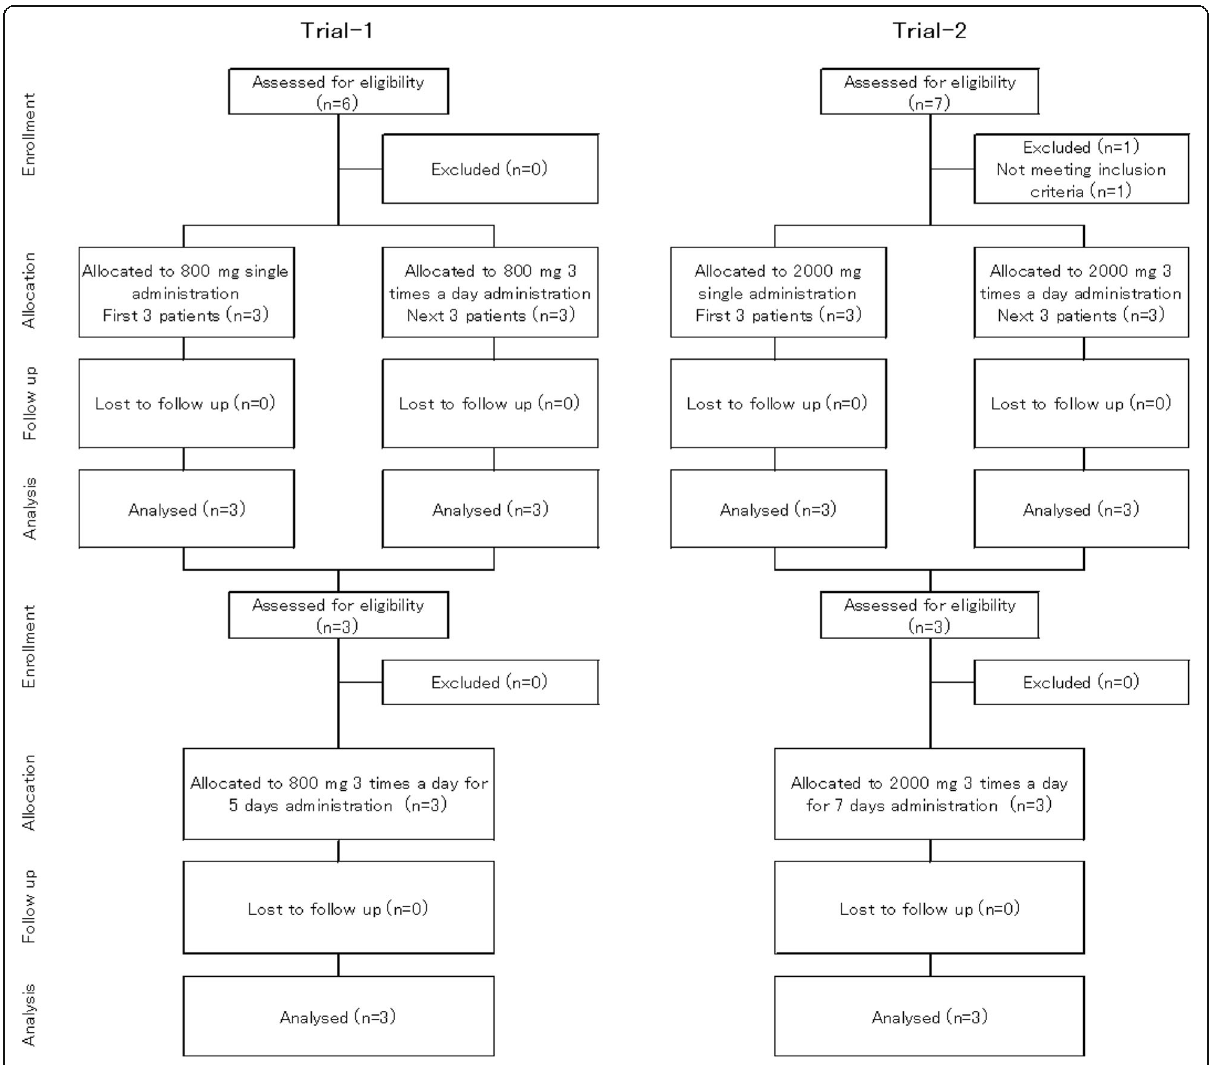
Fig. 2 CONSORT flowchart of the trial through the two phase I